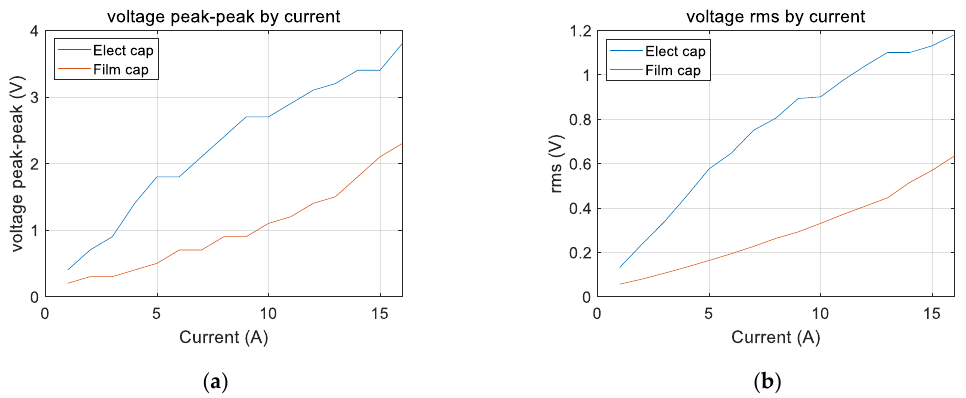
Figure 20. ( a ) Peak-to-peak voltage of capacitor. ( b ) RMS value of the AC component of capacitor voltage obtained by the electrolytic and film capacitors versus motor currents. Table 4. Capacitor RMS current at a speed range of 800–2000 rpm.